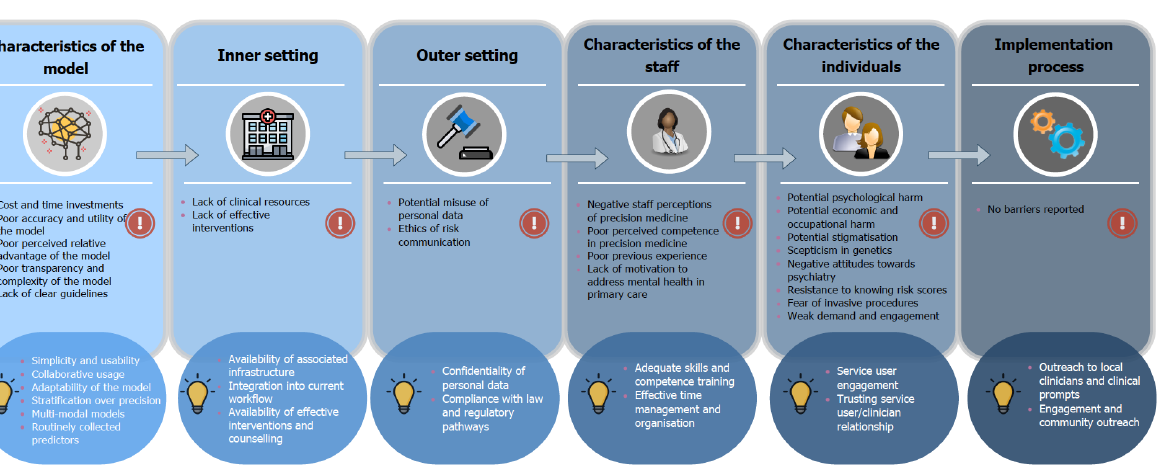
Figure 5. A high-level visual summary of the identified barriers and facilitators which may impact upon the real-world implementation of precision psychiatry approaches, structured according to the Consolidated Framework for Implementation Research (CFIR).